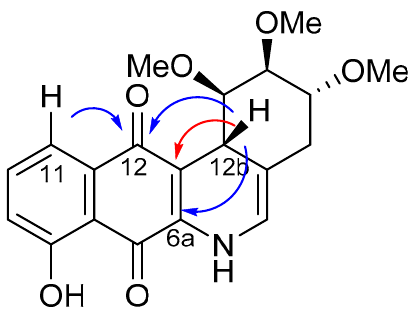
Figure 3. Major HMBC correlations observed for compound 16b . The 3 J HC and 2 J HC correlations are shown in blue and red, respectively.